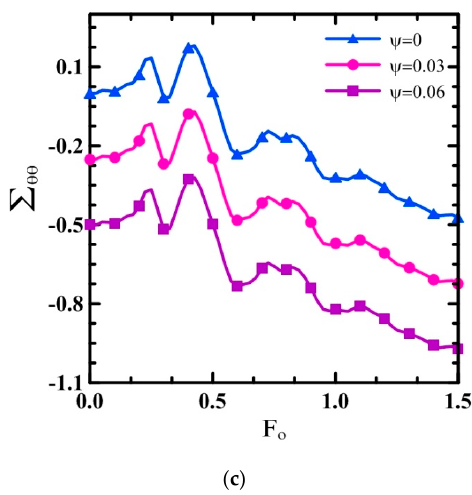
Figure 14. ( a – c ): Time histories of the thermoelastic field variables against the external electrical voltage n = 1, h c / h p = 5, θ 0 = 75 ◦ , ξ = 0.5, θ = 0.5 θ 0 , τ = 0.2